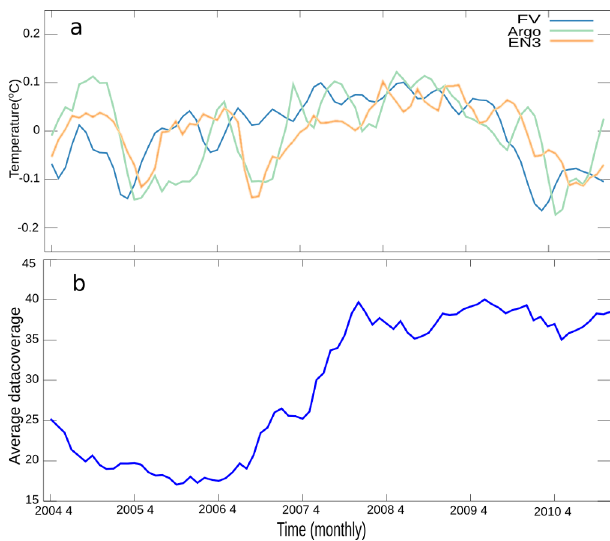
Fig. 9. (a) deseasoned OHC for the basin-wide North Atlantic sec- tion from 26 ◦ and 36 ◦ N. The FV (blue), Argo (green) and EN3 (yellow) data are shown. Note the good agreement after mid-2007, which is most likely due to the increased data coverage of the Argo floats. (b) the average number of Argo profiles in a 1500km radius around each 2.5 ◦ grid point. The time of the RAPID-based time series is shown from April 2004 to January